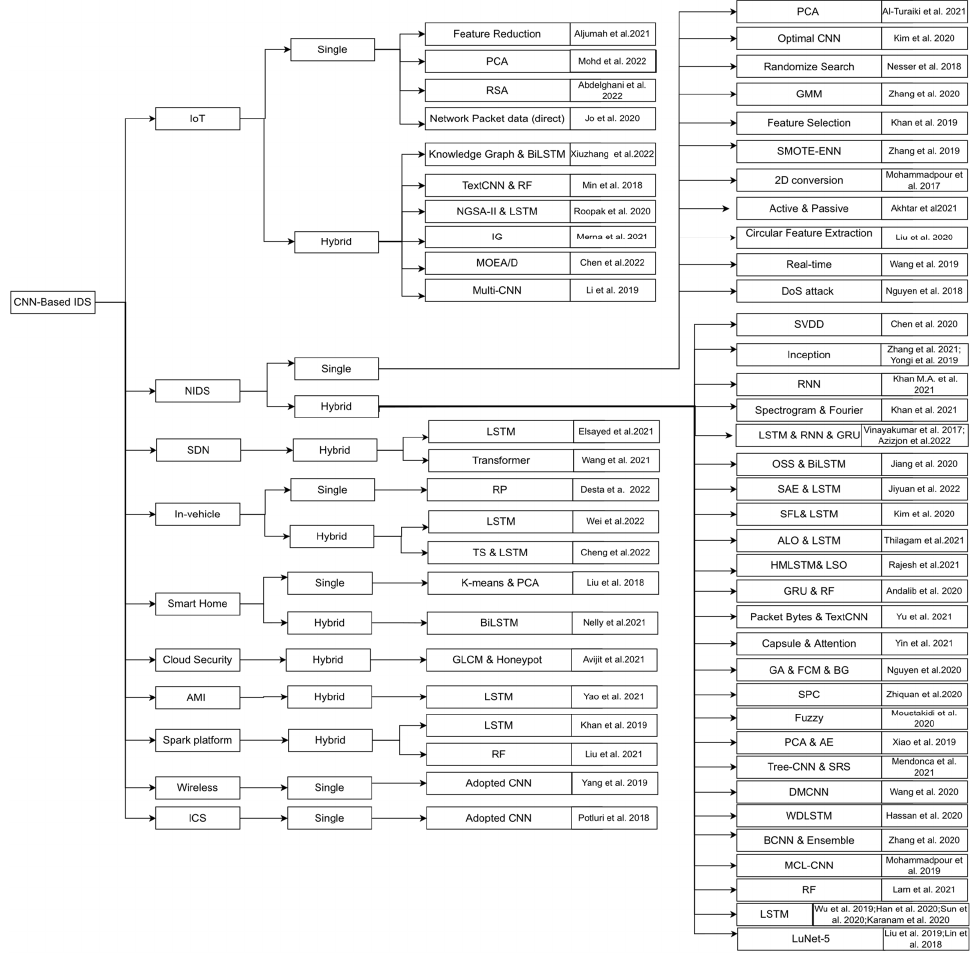
Figure 1. Taxonomy of CNN-based IDSs [3,15–78].